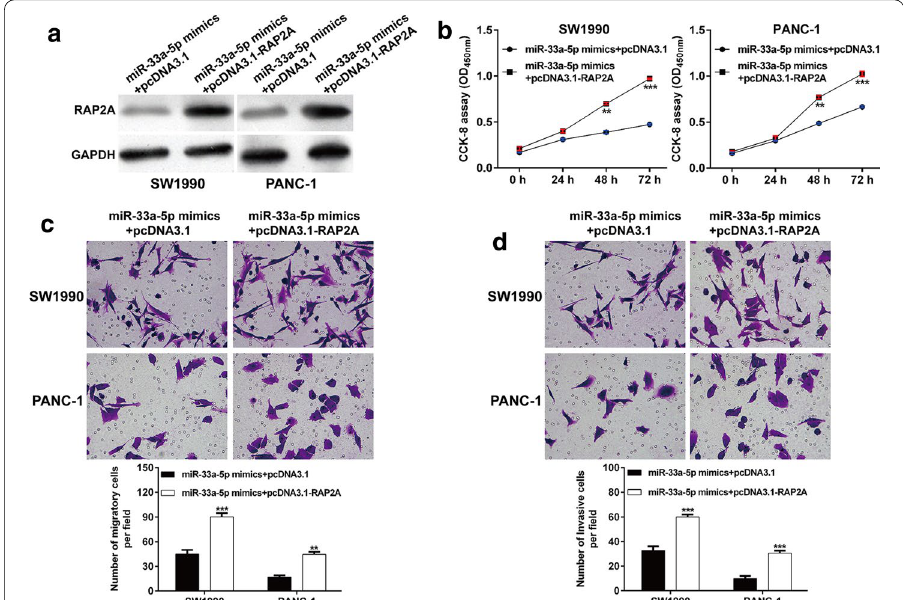
Fig. 6 RAP2A reintroduction attenuated the effects of miR-33a-5p overexpression. SW1990 and PANC-1 cells were co-transfected with the miR-33a-5p mimics and either pcDNA3.1-RAP2A or pcDNA3.1. A RAP2A protein expression was determined using western blot analysis in the aforementioned cells. The transfected cells were subjected to the CCK-8 assay ( B ), Transwell migration ( C ) and invasion ( D ) assays, respectively. ** p < 0.01, *** p < 0.001 vs. the miR-NC pcDNA3.1 +